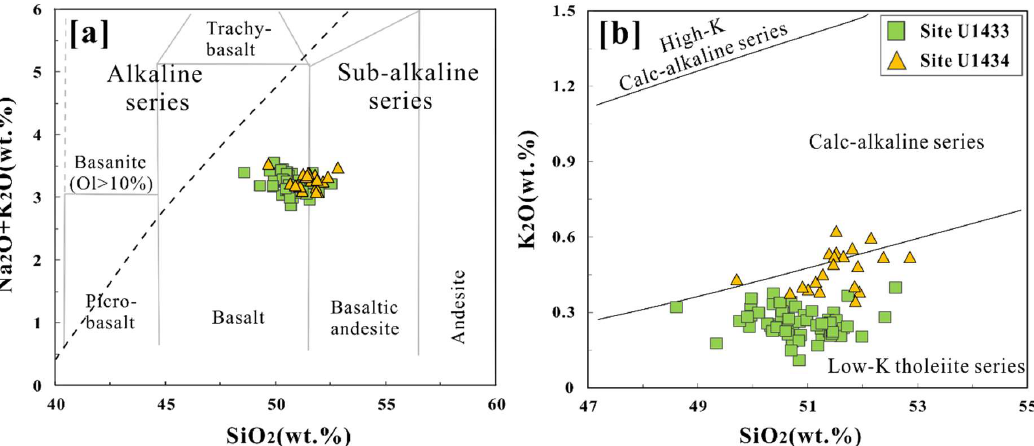
Figure 5. Classification diagrams of ( a ) total alkalis (Na 2 O + K 2 O) vs. SiO 2 (TAS) and ( b ) magma series diagrams of K 2 O versus SiO 2 for U1433 and U1434 basaltic samples.